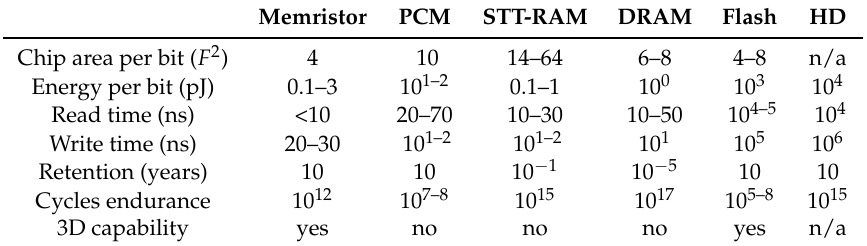
Table 1. Characteristics of various storage devices (for details see [50]). The table compares to memristor technology to competitors like Phase-Change Materials (PCM) and more standard devices based on Spin-Transfer Torque (STT), dynamic random-access memory (DRam), Flash and hard disk (HD).